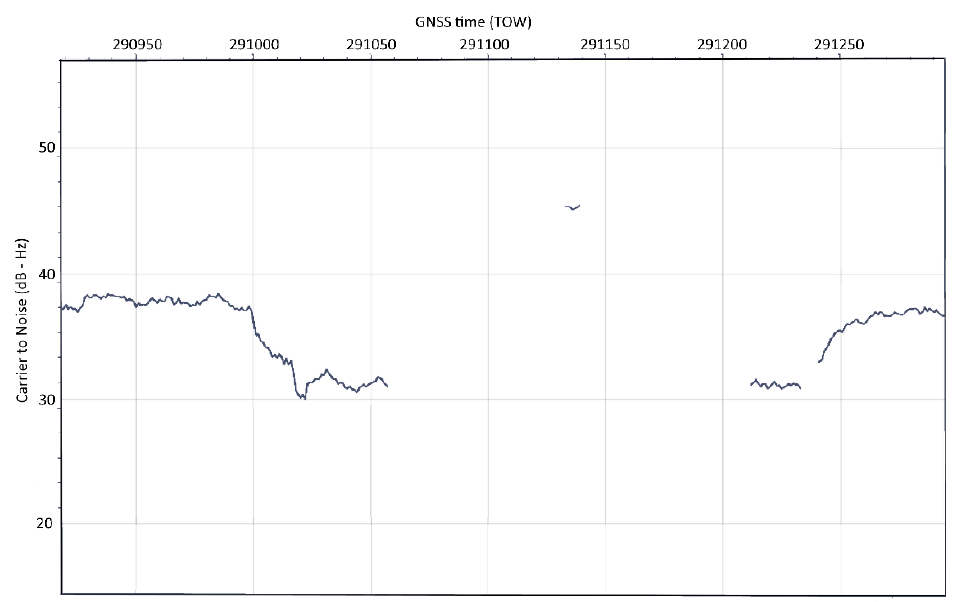
Sensors 2019 , 19 , x FOR PEER REVIEW